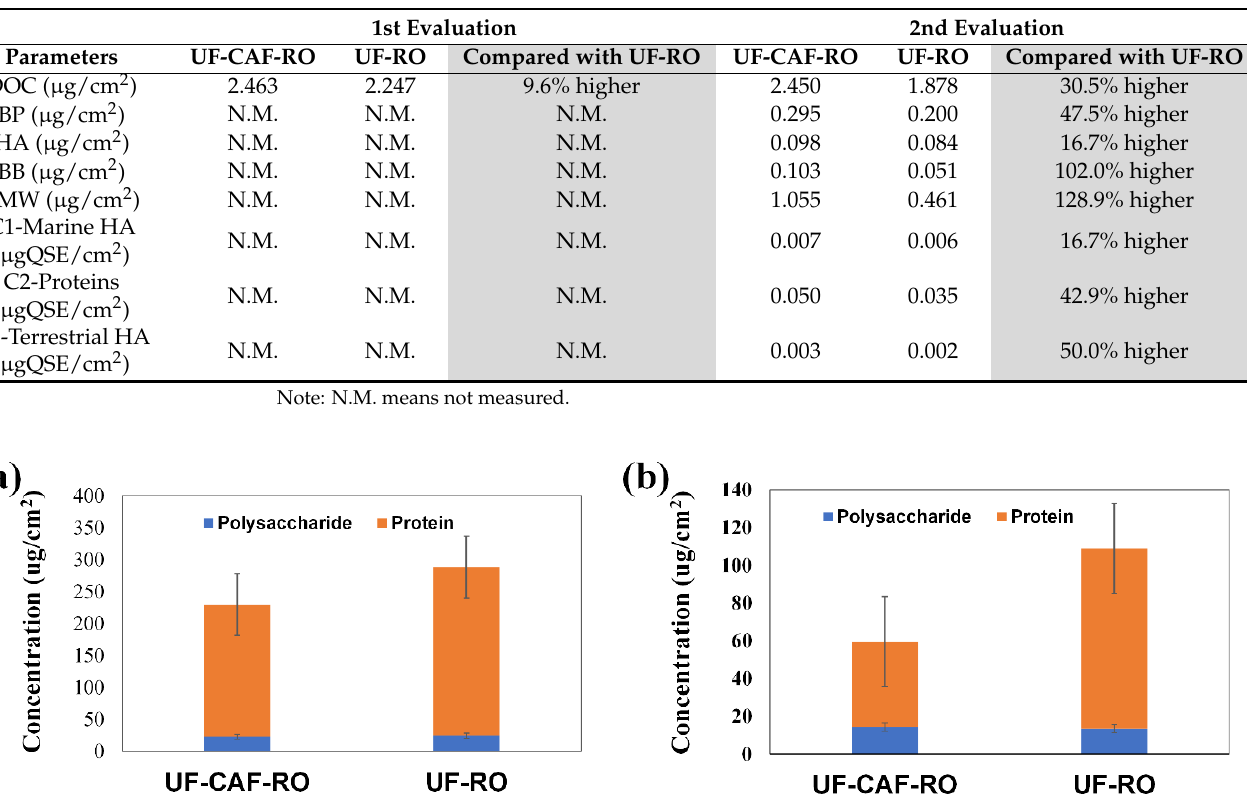
Figure 6. Live/dead cell count on the fouled RO membranes with and without CAF pre-filtration in the ( a ) 1st evaluation and ( b ) 2nd evaluation.